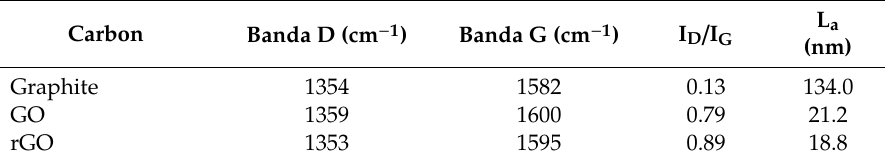
Table 4. Parameters obtained from Raman spectra.